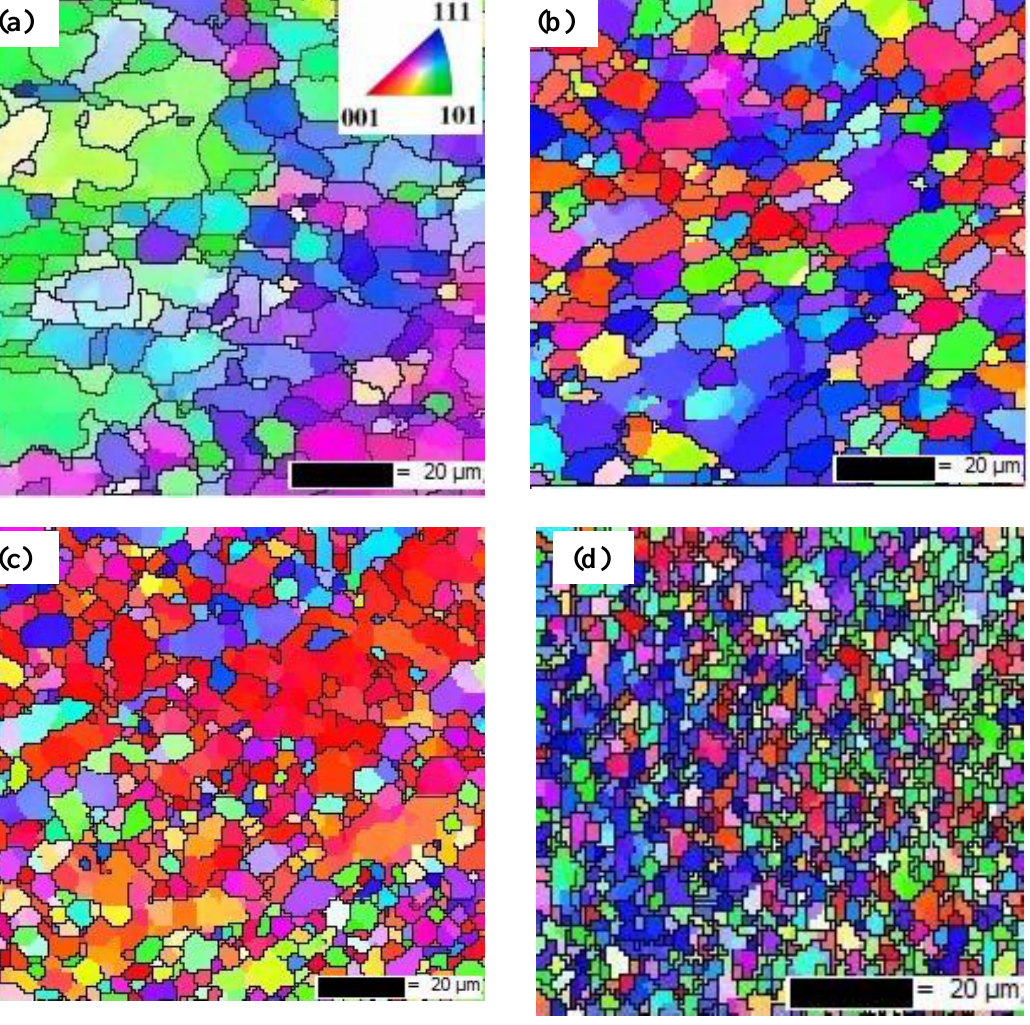
Figure 5. Grain structure in WNZ of (a) NAC (b) S-RW (C) S-IW (d) U-RW Figure 7. Grain structure in WNZ of ( a ) NAC ( b ) S-RM ( c ) S-IM ( d )